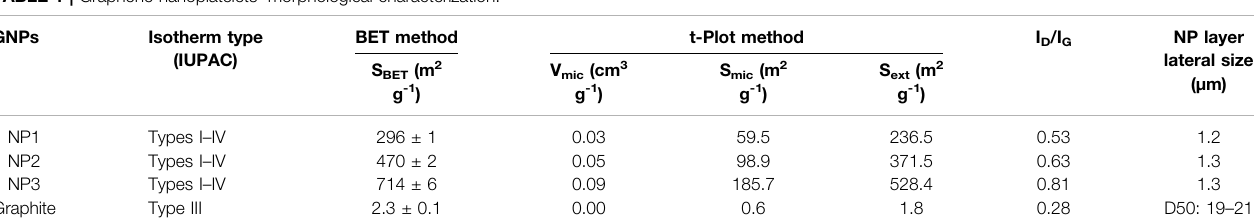
TABLE 1 | Graphene nanoplatelets ’ morphological characterization. GNPs